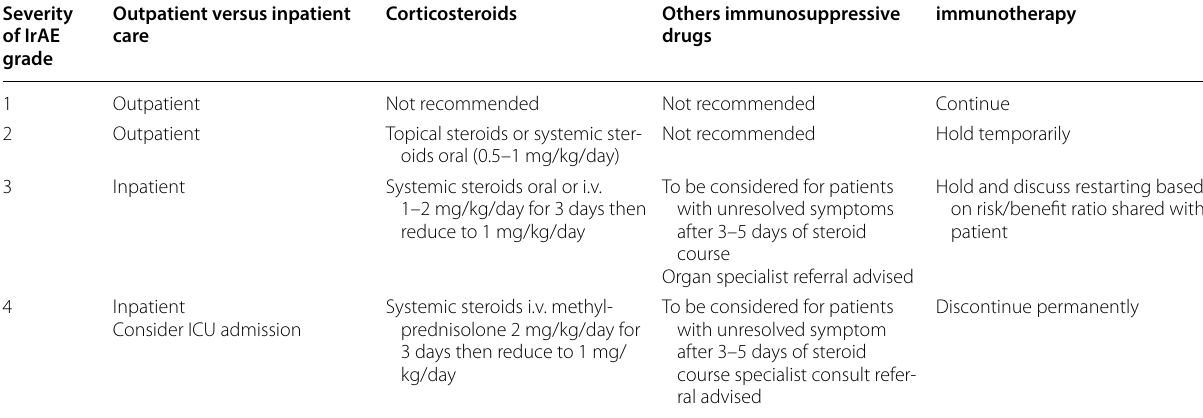
Table 1 Definition of severe immune‑related adverse events and diagnostic workup. From [84] and [73] Guidelines from American Society of Clinical Oncology (www.asco.org). CTCAE: common terminology criteria for severe adverse